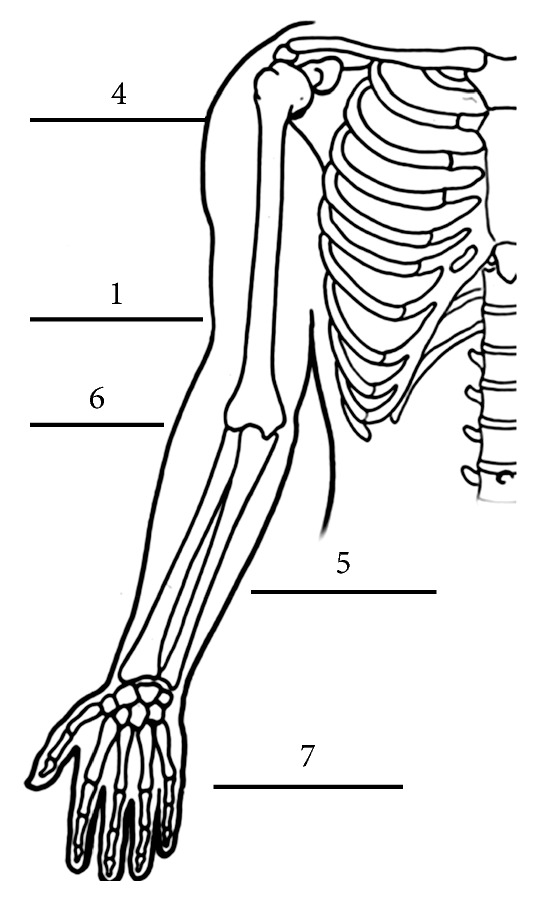
Graphical depiction of the incidence of upper extremity tumor locations by region.